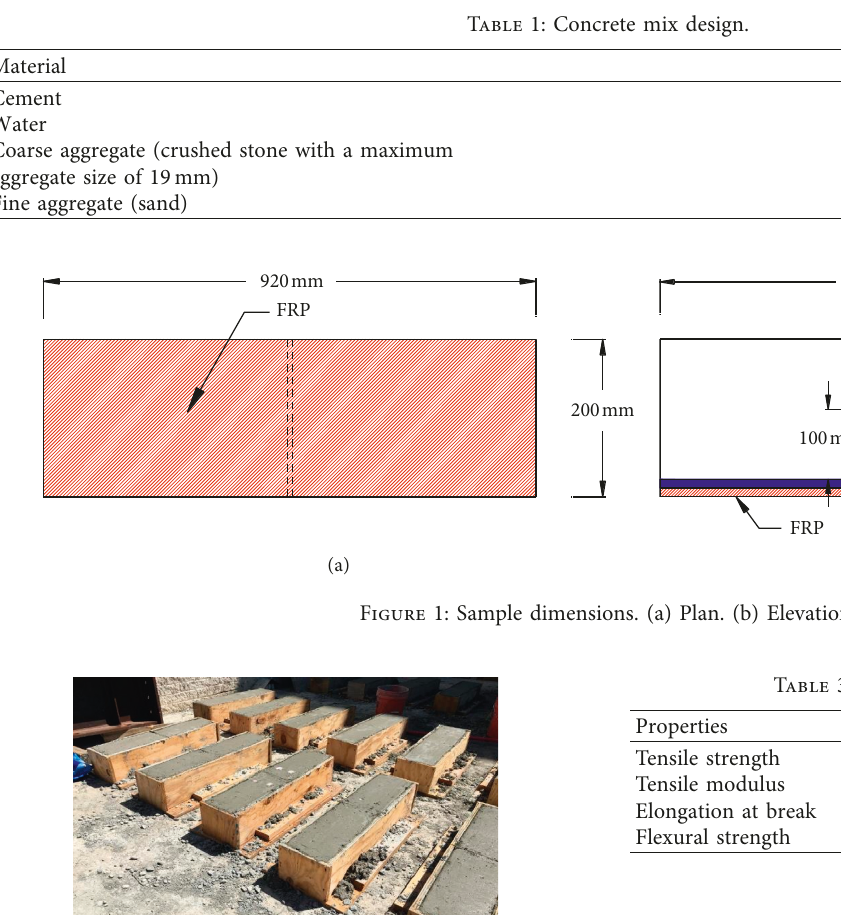
Table 4: Type 2 epoxy